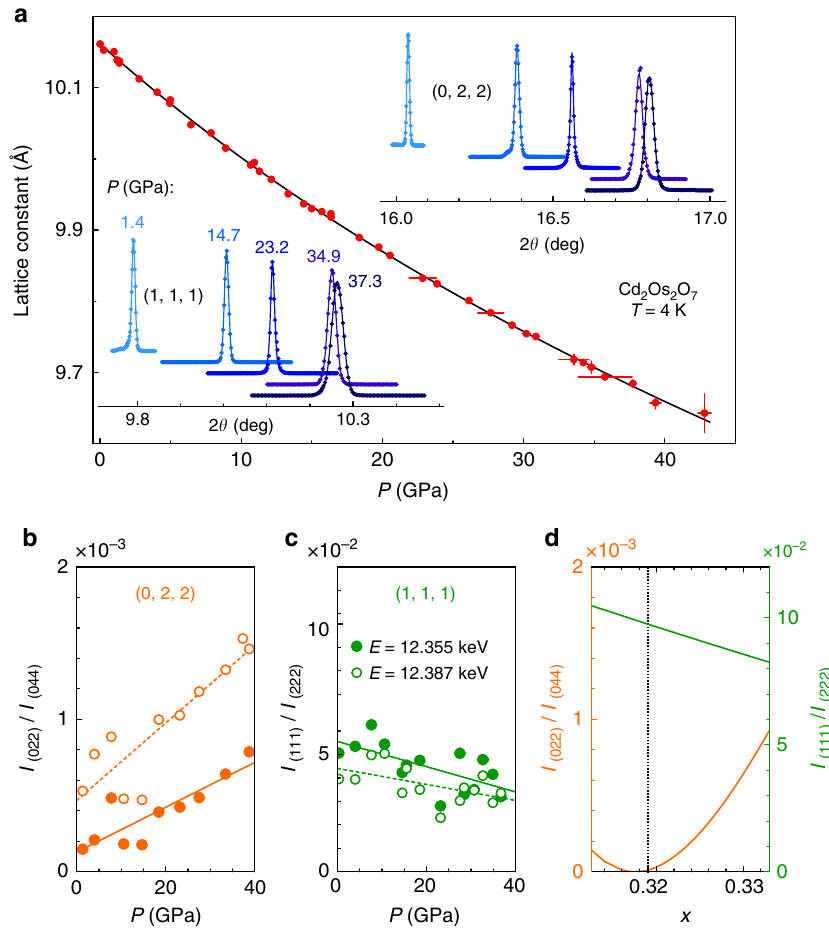
Fig. 3 Lattice evolution under pressure. a Pressure evolution of the lattice constant (red solid circles) was fi t to a two-parameter Birch equation of state with B = 190.4 ± 3.6 GPa, and B ’ = 4.2 ± 0.2. Vertical error bars represent 1 σ s.d. counting statistics, and horizontal error bars represent the full range